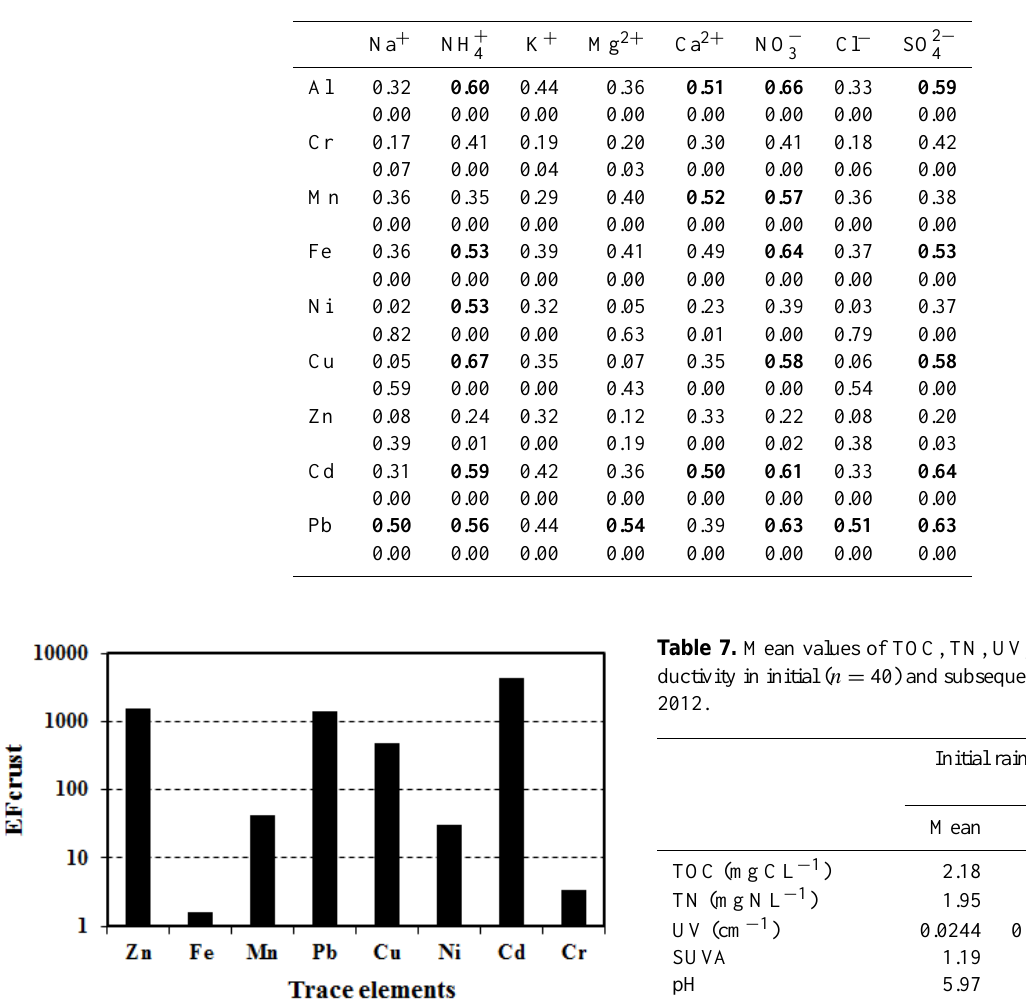
Table 6. Correlation coefficients and P value between ions and trace metals in rainwater 1 samples from Gwangju ( n = 113).